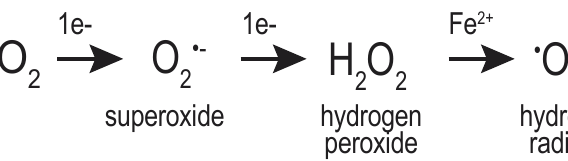
Figure 1. Reactive oxygen species. Scheme shows several of the types of ROS generated through the successive reduction molecular oxygen (O 2 ).